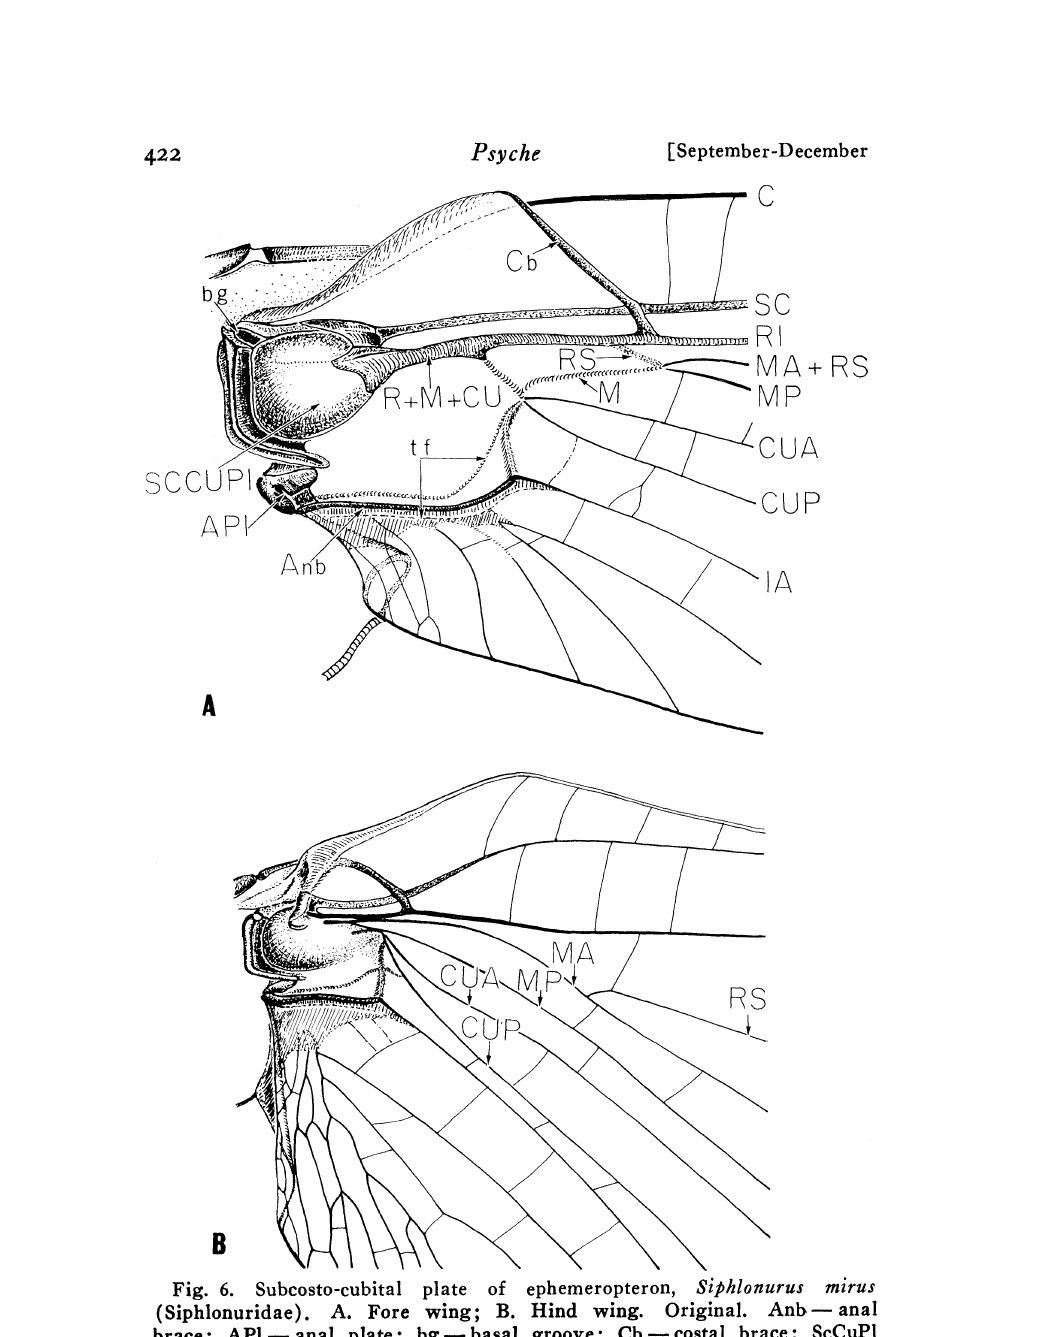
Fig. 6. Subcosto-cubita plate of ephemeropteron, Siphlonurus mirus (Siphlonuridae). A. Fore wing; B. Hind wing. Original. Anb--anal brace API-- anal plate bg--- basal groove; Cb costal brace ScCuP1 subcosto-cubital plate; tf transverse furrow.